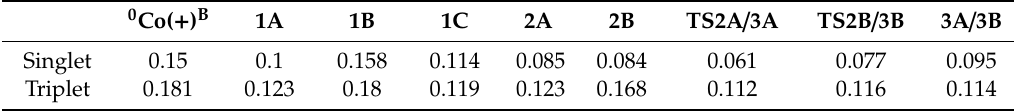
Figure 9. Comparison of the energy profiles for L s Co(+) B (L = Ar PDI, s means spin states, here is singlet and triplet, the B means the cobalt metal having no other coordination besides the L) on addition of [CH 3 ] − or [AlMe 4 ] − or C 2 H 4 .